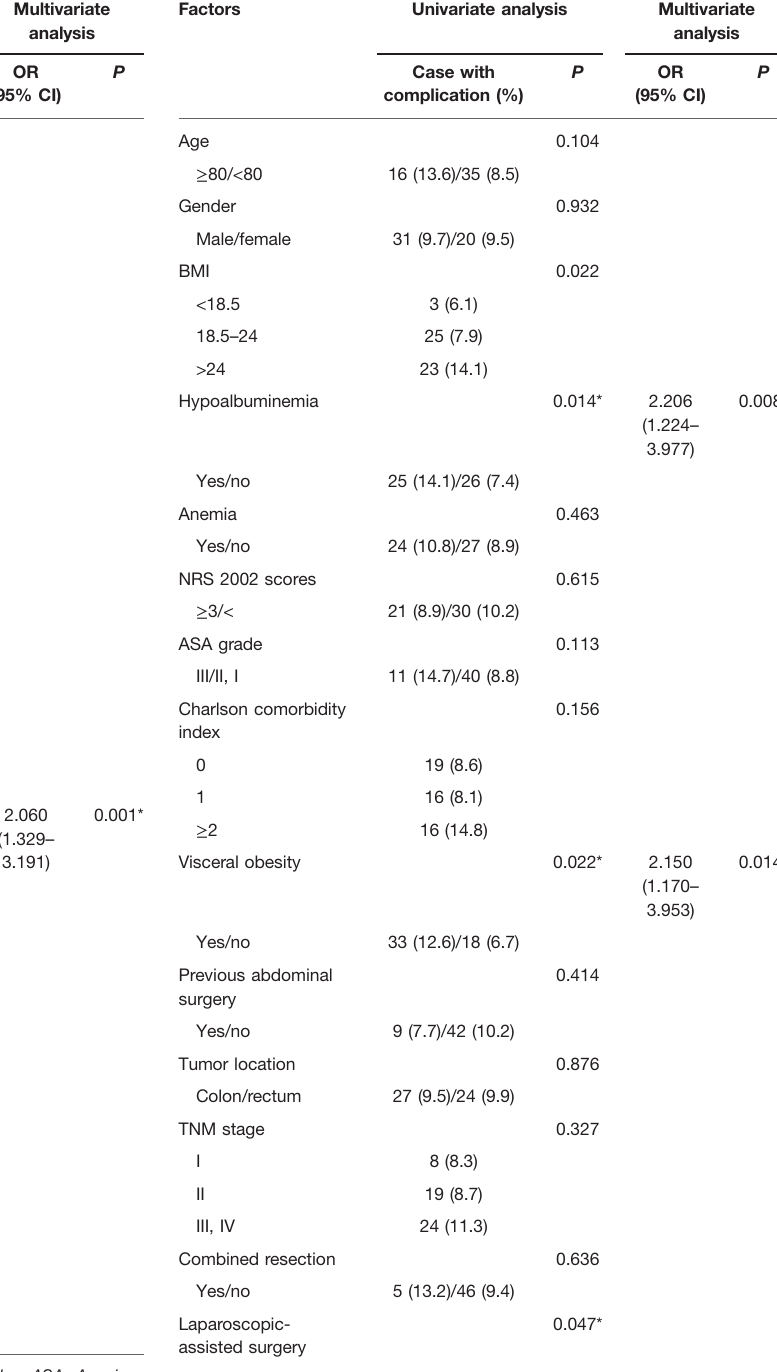
TABLE 5 | Univariate and multivariate logistic regression analysis of risk factors for medical